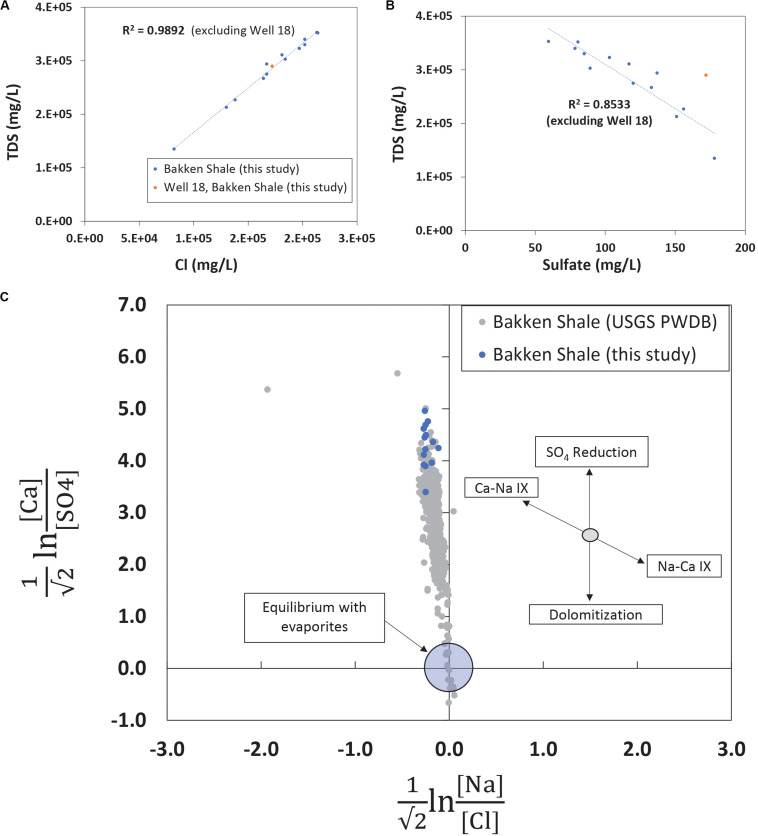
(A) TDS and chloride measurements plotted for produced waters in this study. Linear trendlines report a high linear correlation value, displaying that chloride is the primary anion and well 11, with its lower TDS value, does not have an anomalous chloride value. The trendline excludes well 18, a sample that, based on its geochemistry and age, likely represents a mix of flowback and produced water. (B) TDS and sulfate measurements plotted for produced waters in this study. There is a higher linear association (R2 = 0.8533) for these analytes when the youngest and spatially unique sample, well 18, is excluded. Based on measurements from this study and previous research, the elevated sulfate in well 18 could be related to residual chemicals from hydraulic fracturing operations or the product of flowback waters. (C) Isometric log-ratios for produced waters from the Bakken Shale. Data collected with this study are shown in blue while all data available from the Bakken region in the USGS PWDB (Blondes et al., 2019) is shown in gray. This figure portion is modified from Engle et al. (2016).